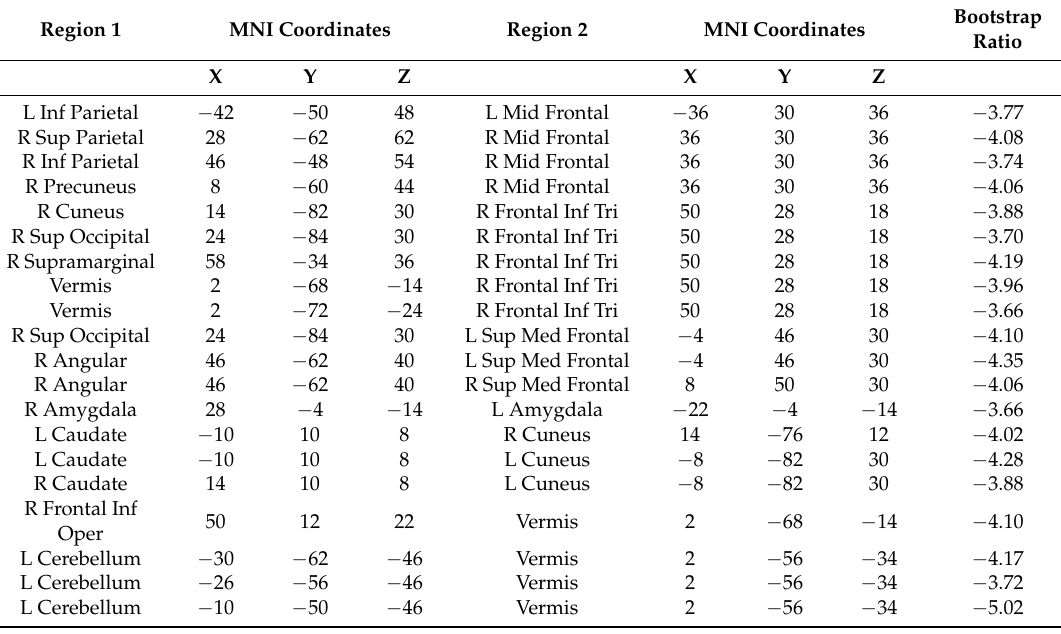
Table A1. Areas of reduced functional connectivity observed between individuals with MCI compared to cognitively healthy controls.